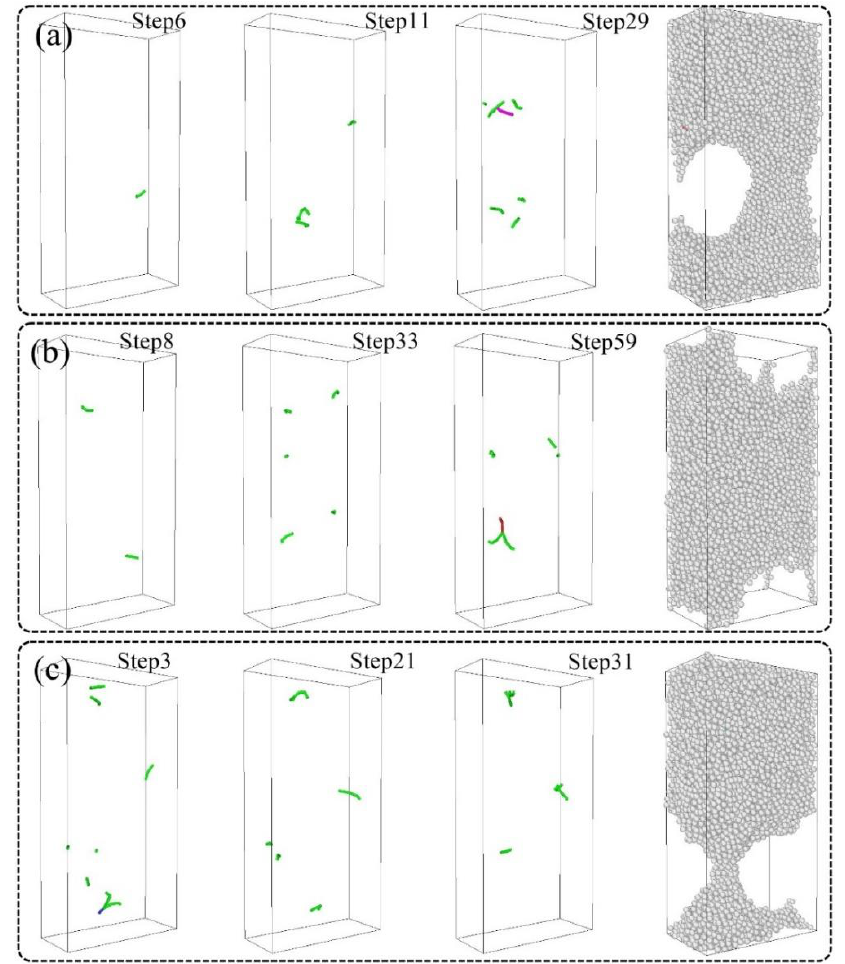
Figure 9. Molecular dynamics simulation of 2205 additive parts with different volume ratios of fer- rite and austenite ( a – c ) dislocation changes at bottom, middle and top area during tensile simula- tion.